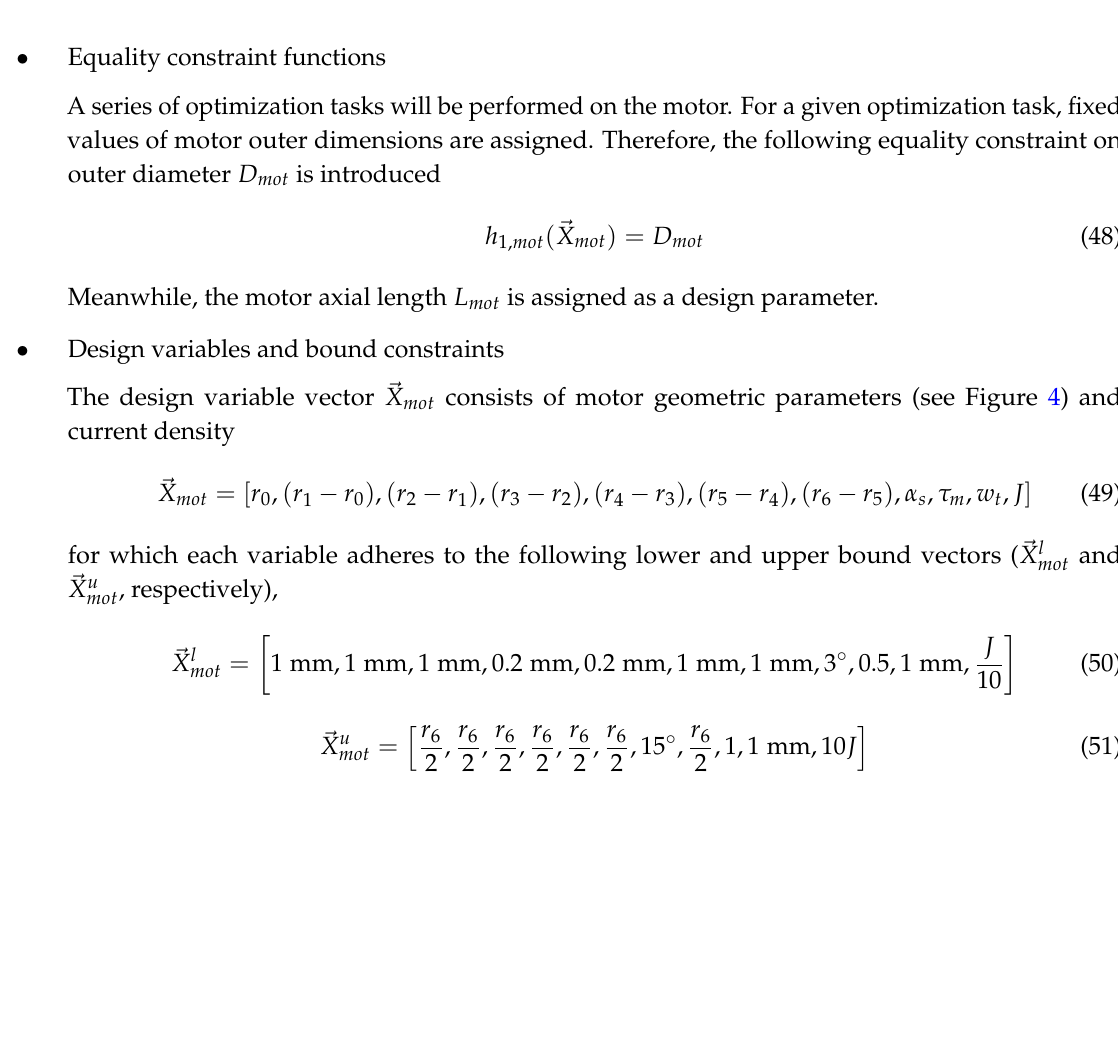
Figure 13. Torque ripple as a function of motor rotor mechanical position θ mot